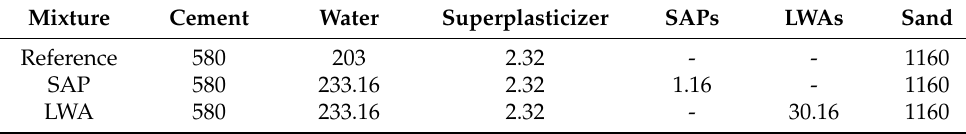
Table 1. Mixture compositions of reference, SAP and LWA mortar (kg/m 3